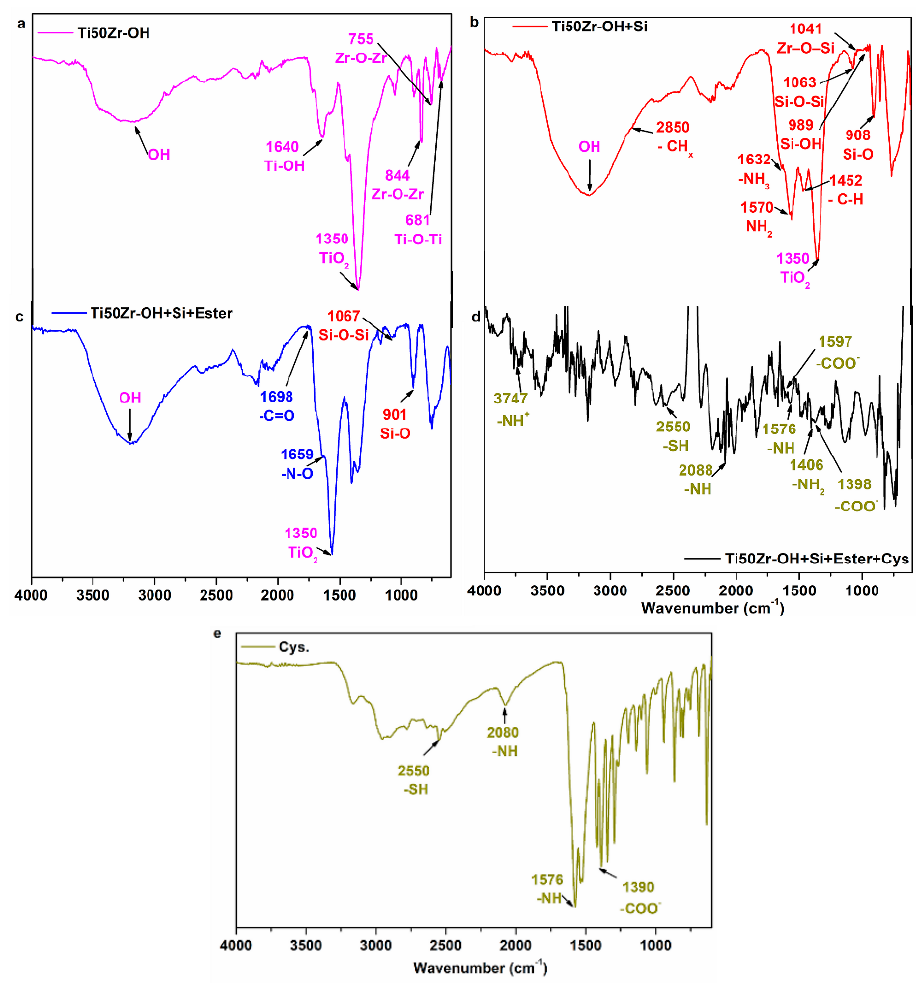
Figure 1. FTIR spectra of: ( a ) Ti50Zr substrate after NaOH treatment; ( b ) Ti50Zr–OH+Si; ( c ) Ti50Zr–OH+Si+Ester; ( d ) Ti50Zr-cys; and ( e ) Cys.